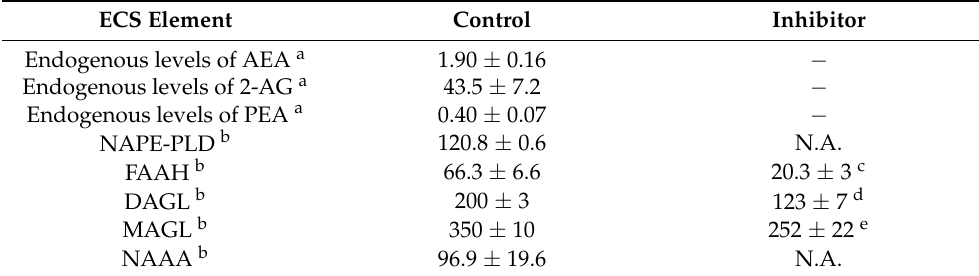
Table 1. Endogenous levels and metabolism of AEA, 2-AG, and PEA in the Mediterranean mussel Mytilus galloprovincialis hemocytes.